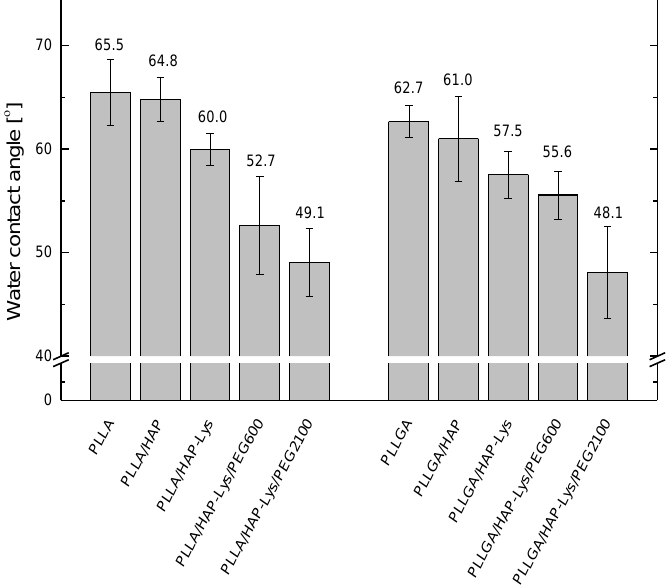
Figure 5. Water contact angle of poly( L -lactide) (PLLA), poly( L -lactide-co-glycolide) (PLLGA), and composite films.